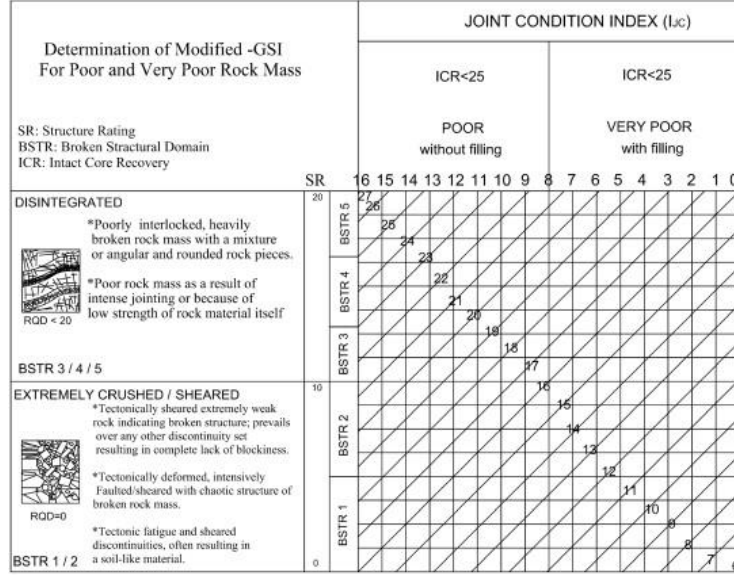
Figure A9. Quantified GSI chart [51].